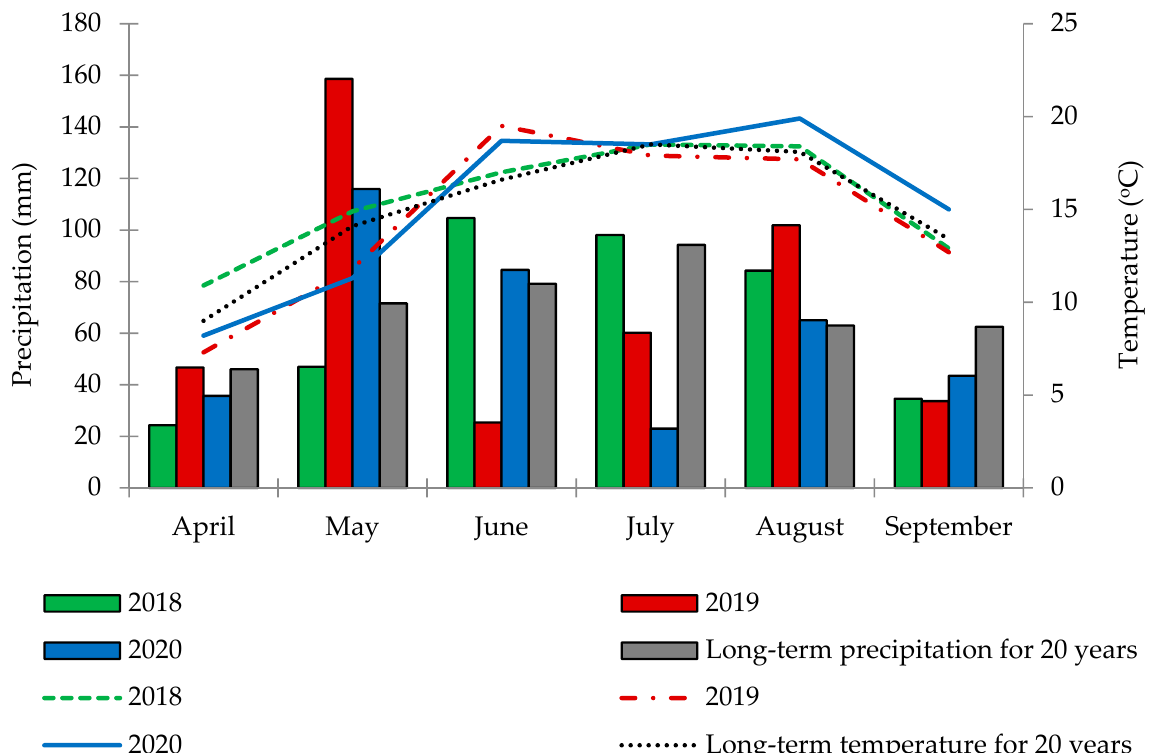
Figure 1. Seasonal weather conditions in the study years.